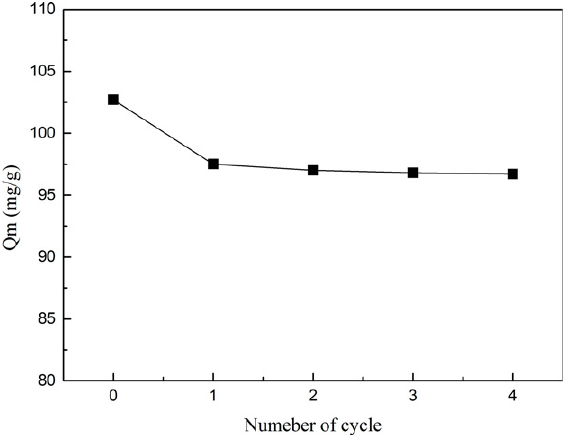
Figure 16: Adsorption capacities of amino-functionalized MCM-41 adsorbent after